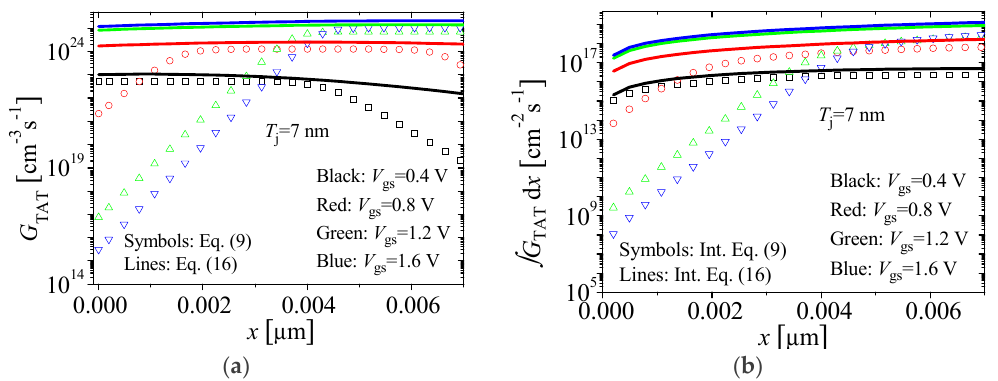
Figure 5. ( a ) G TAT calculated from Equation (9) (symbols) compared against G TAT calculated from Equation (16) (lines) for V gs = 0.4, 0.8, 1.6, and 2.0 V shown by black, red, green and blue colors respectively, for V ds = 0.5 V and T j = 7 nm. ( b ) Integrated G TAT , (cid:1516) (cid:1833) (cid:3021)(cid:3002)(cid:3021) (cid:1856)(cid:1876) (cid:2868) annotation as Figure 5a except symbols: Integral of Equation (9), and lines: Integral of Equation (16).